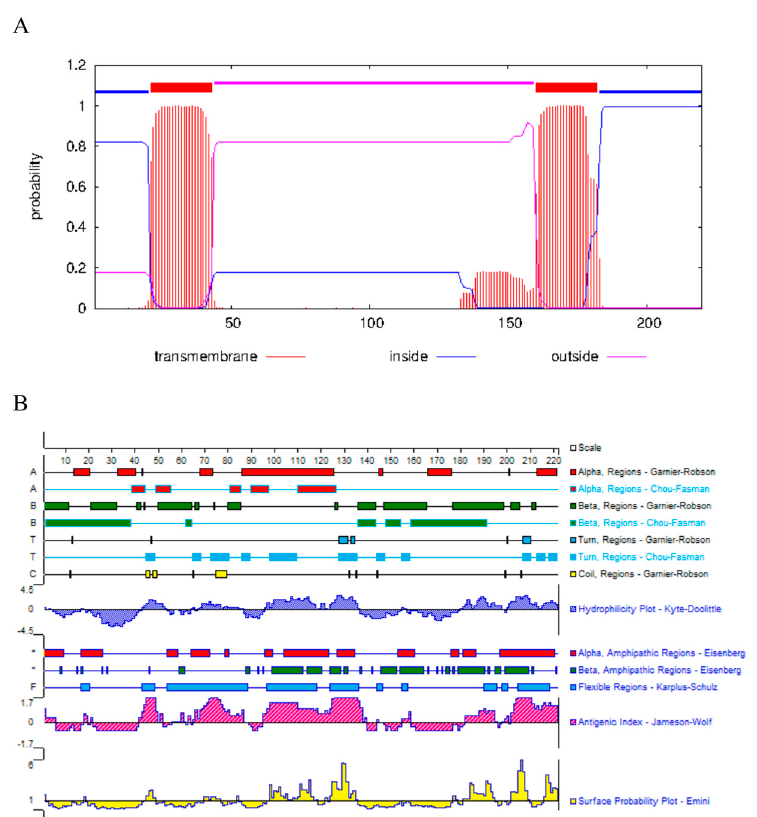
Figure 1. Sequence analysis of GRA3. ( A ) Transmembrane domain analysis. Two transmembrane domains are shown. ( B ) Antigenicity analysis.